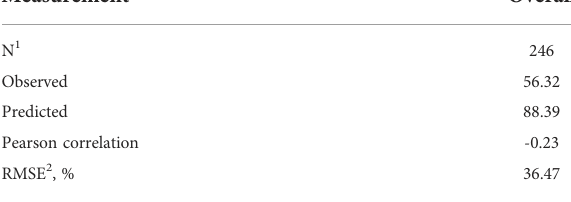
TABLE 1 Overall descriptive statistics when evaluating measured heart rates versus those obtained from a heart rate sensor. Measurement